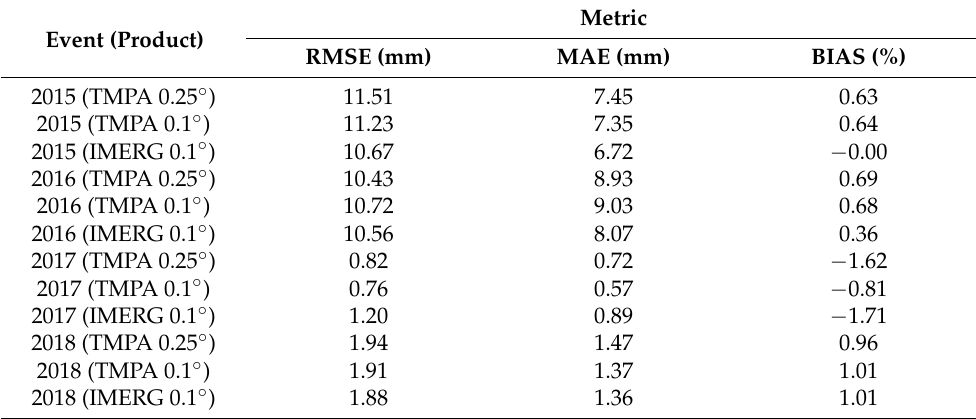
Figure 4. Spearman correlation ( R s ) and p -value ( p s ) between remote sensing data, at spatial resolutions of ( a ) TMPA 0.25°, ( b ) TMPA 0.1°, and ( c ) IMERG 0.1°) and rain gauge records. The solid line represents the fitted linear regression. Table 3. Root Mean Square Error (RMSE), Mean Absolute Error (MAE), and Bias (BIAS) for each recorded event with spatial resolutions specified.